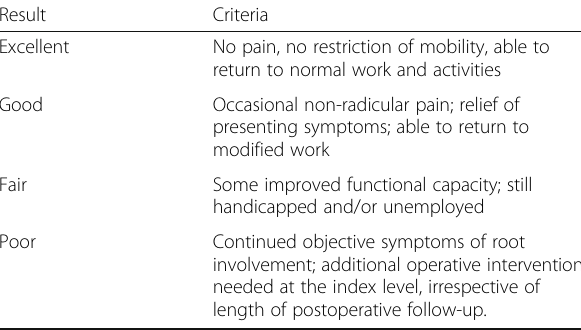
Table 1 Modified MacNab Criteria assessing